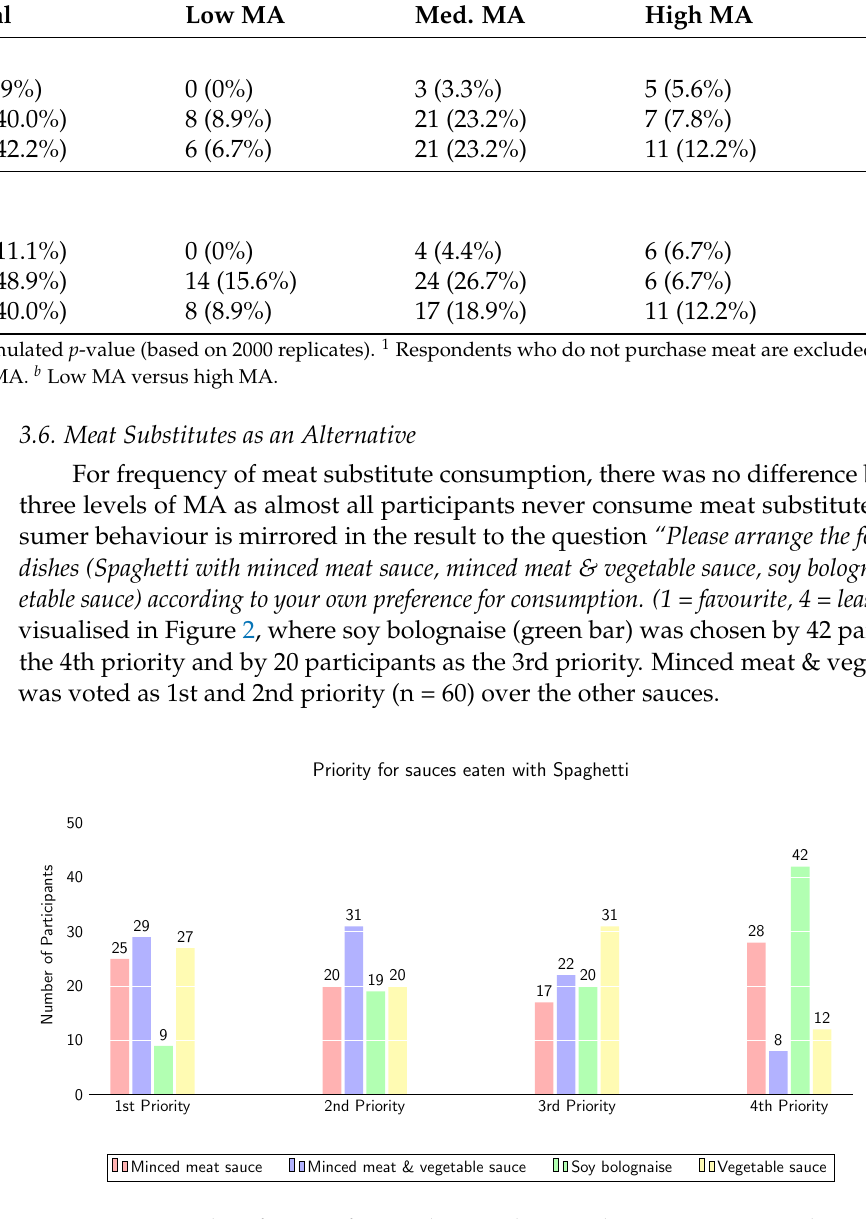
Figure 2. Arranged preferences for spaghetti with minced meat sauce, minced meat & vegetable sauce, soy bolognaise and vegetable sauce, 1 = favourite, 4 = least